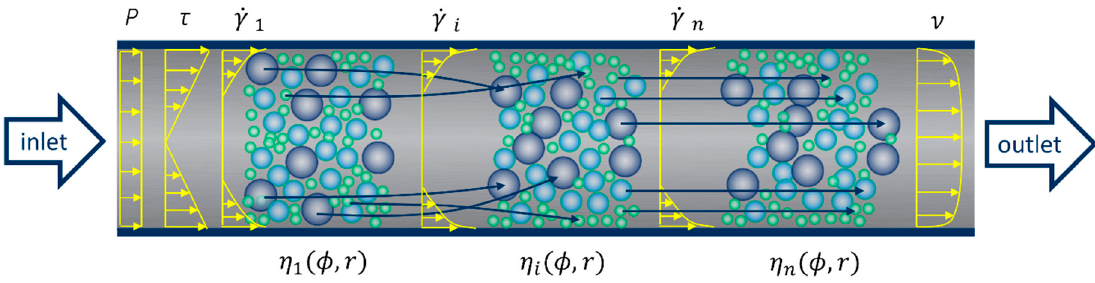
Figure 1. Particle migration during pumping before reaching a steady state.